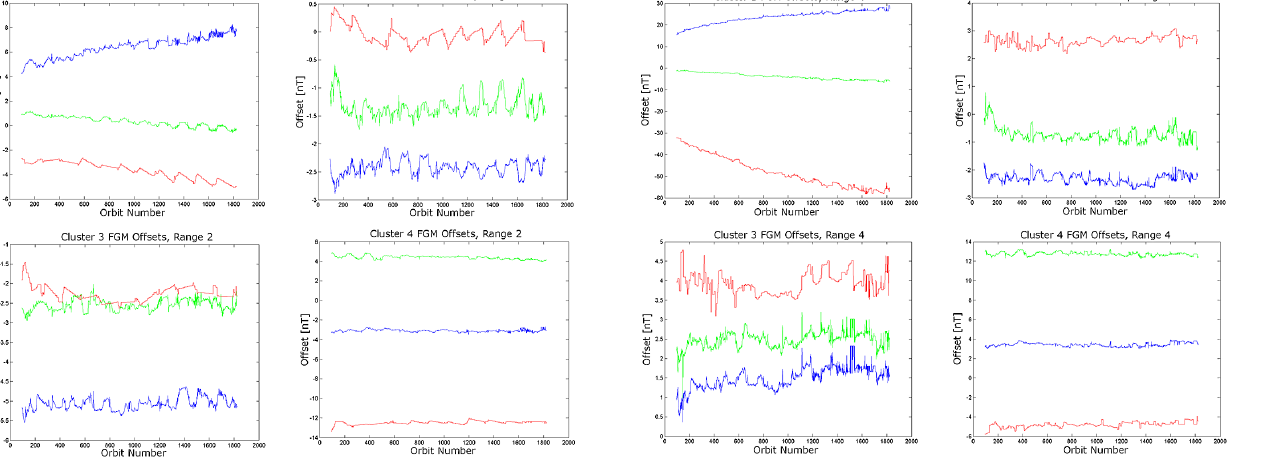
Figure 6. Range 4 spin-axis ( O 1 , red) and spin-plane ( O 2 and O 3 , blue and green) offsets in nanoteslas for orbits 93–1825 (Febru- ary 2001–February